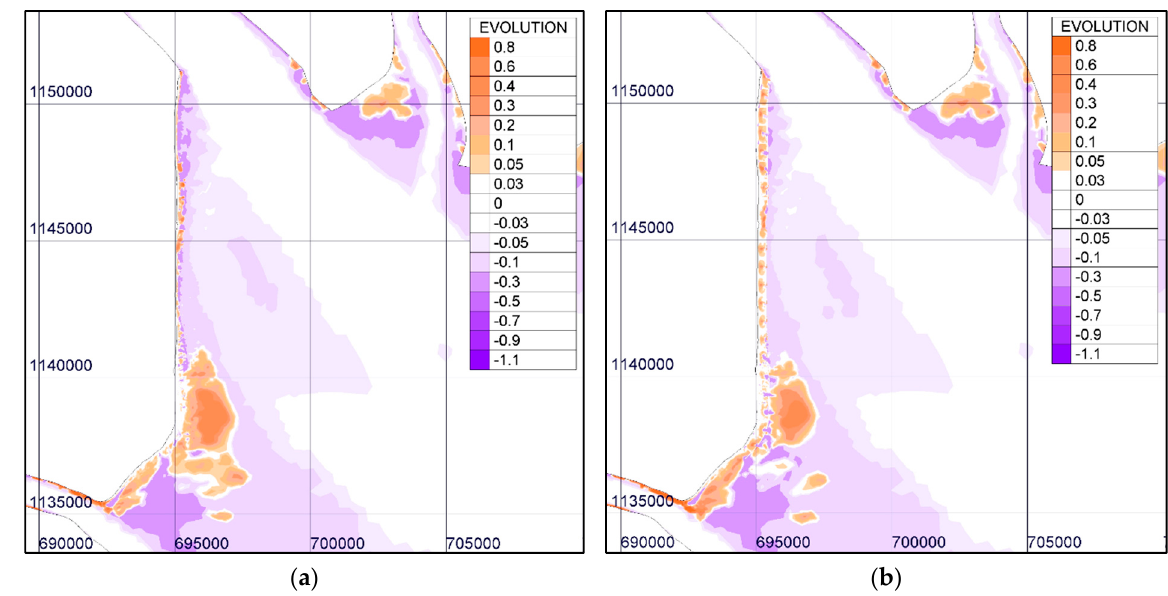
Figure 16. Impact of the breakwaters (KB3) on morphological changes by TELEMAC after one month in the NE monsoon (January 2014): ( a ) at 1 January 2014, ( b ) at 31 January 2014. Table 4. Net trapping sediment volumes and thickness of different breakwater scenarios for one month in NE (January) of 2014 provided by TELEMAC.